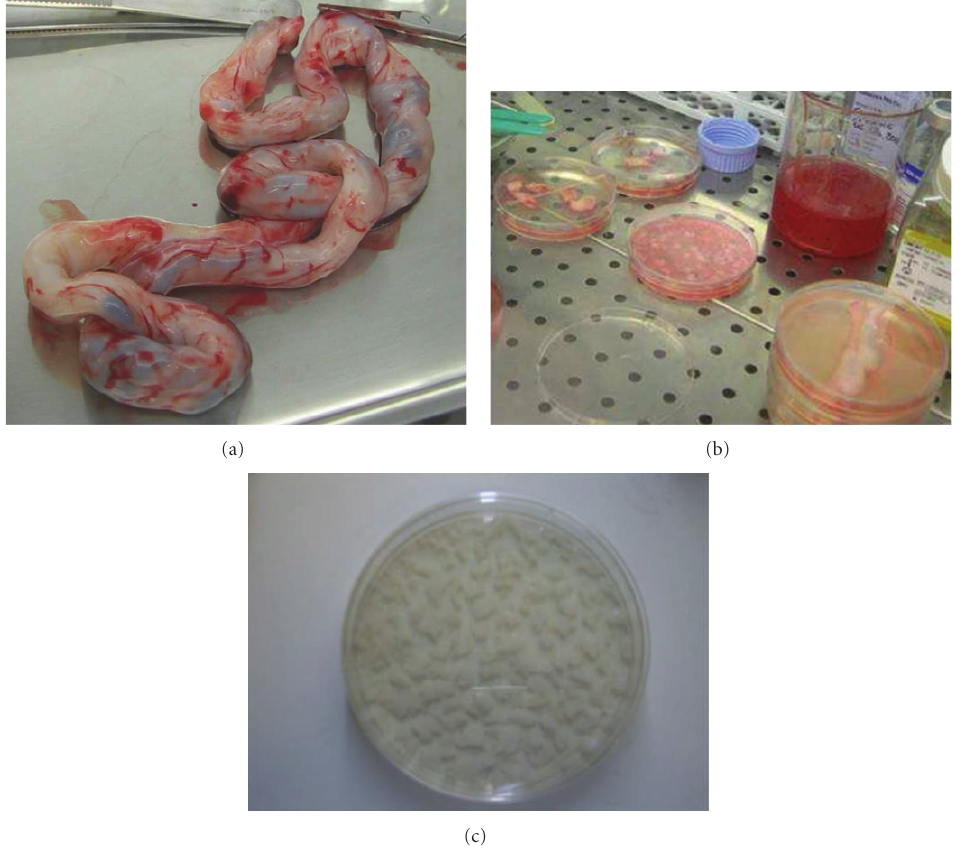
Figure 1: Umbilical cord processing method (a, b,